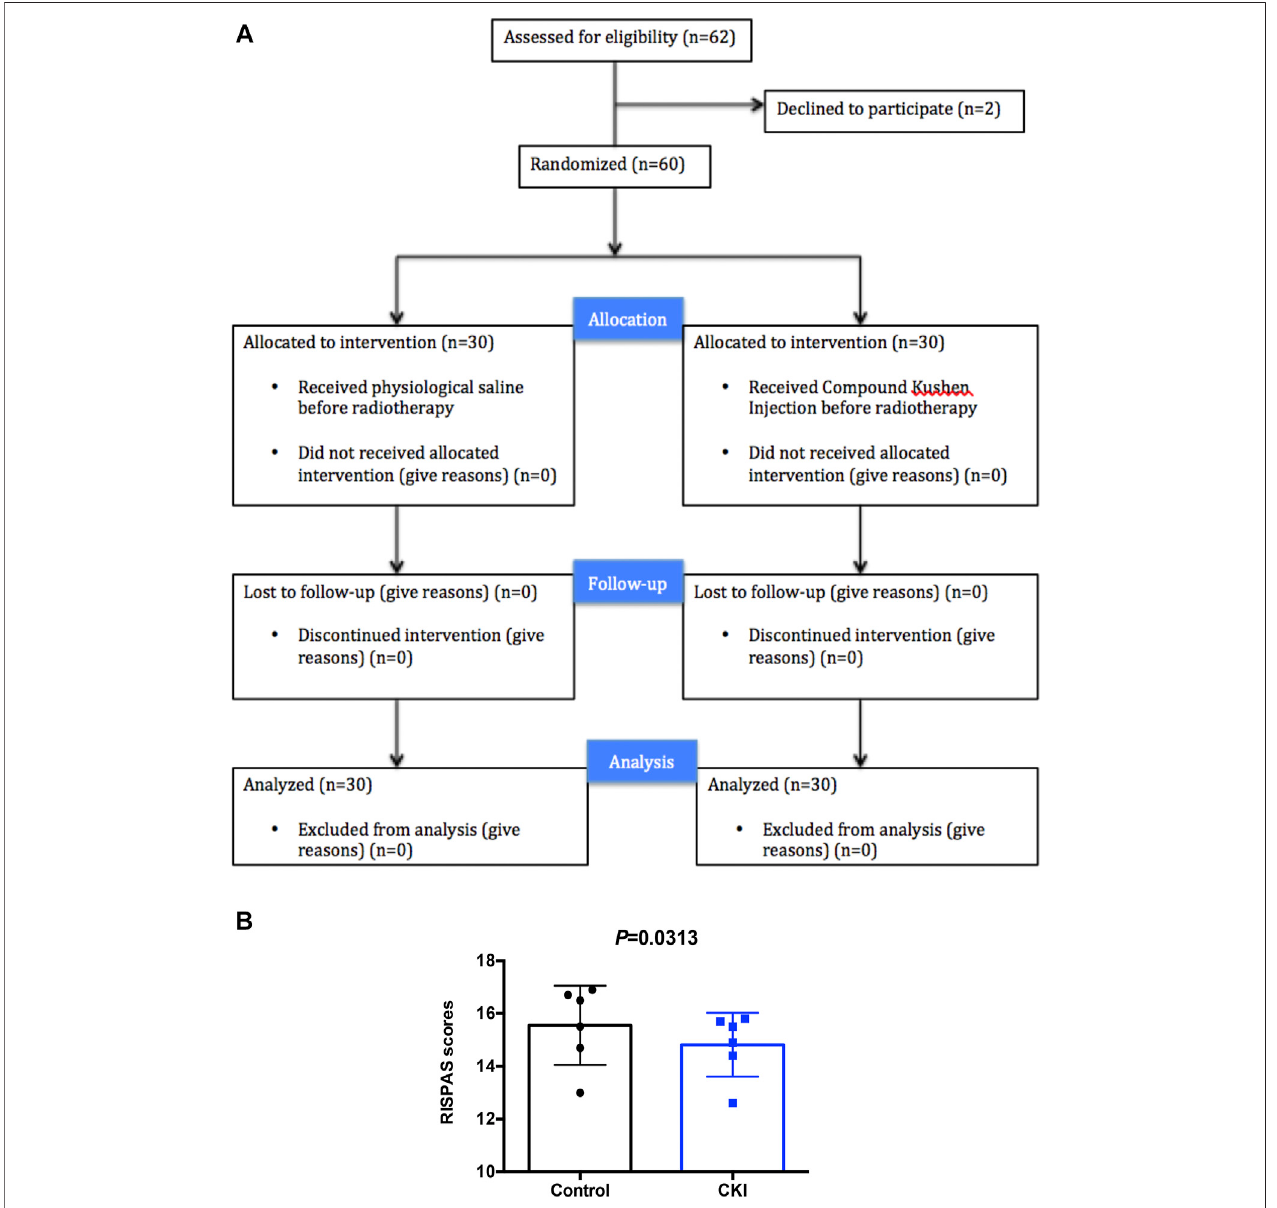
FIGURE 1 | Patients had lower RISPAS scores in the CKI- treated group compared to control group. (A) Participant fl ow through the trial. (B) Graph showing RISPAS scores in the CKI and control group. p (cid:2) 0.0313 ( < 0.05), indicates a signi fi cant difference in the CKI group compared to the untreated control group.